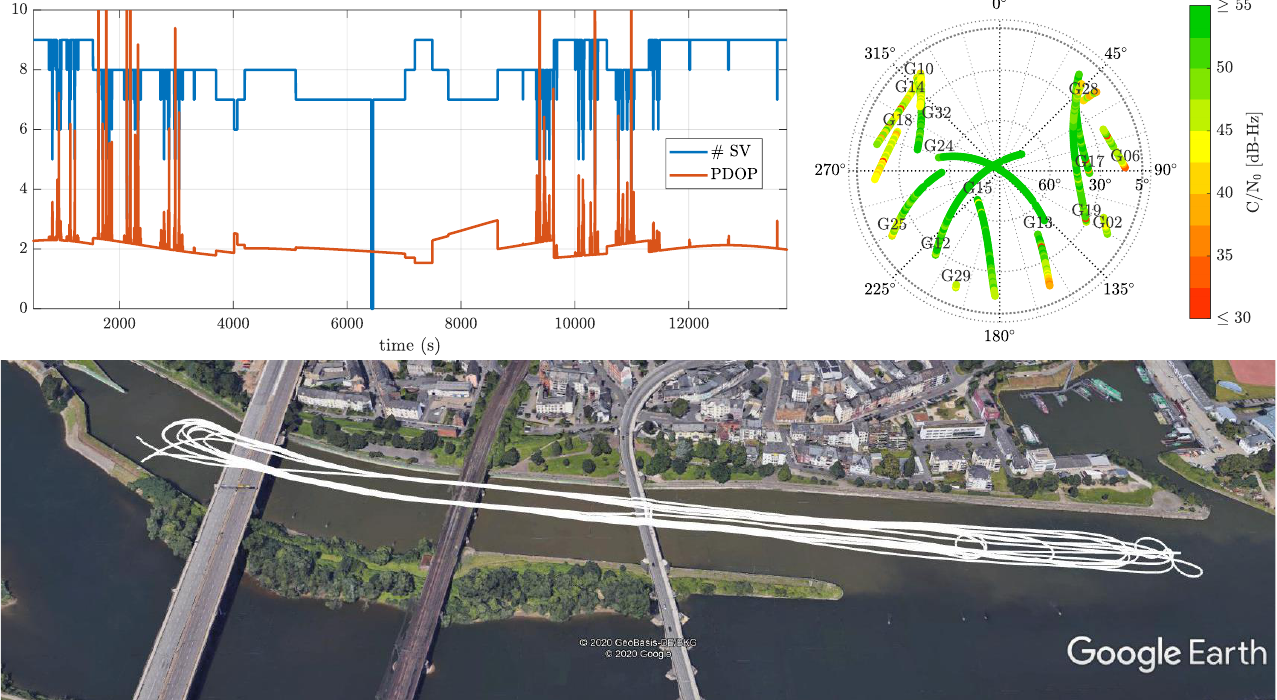
Figure 8. On the upper left, the number of tracked satellites and associated position dilution of precision (PDOP). On the upper right, a skyplot of the scenario, with the colorbar indicating the C/N 0 . At the bottom, the trajectory followed by the tracked vessel during bridge passing, estimated using laser